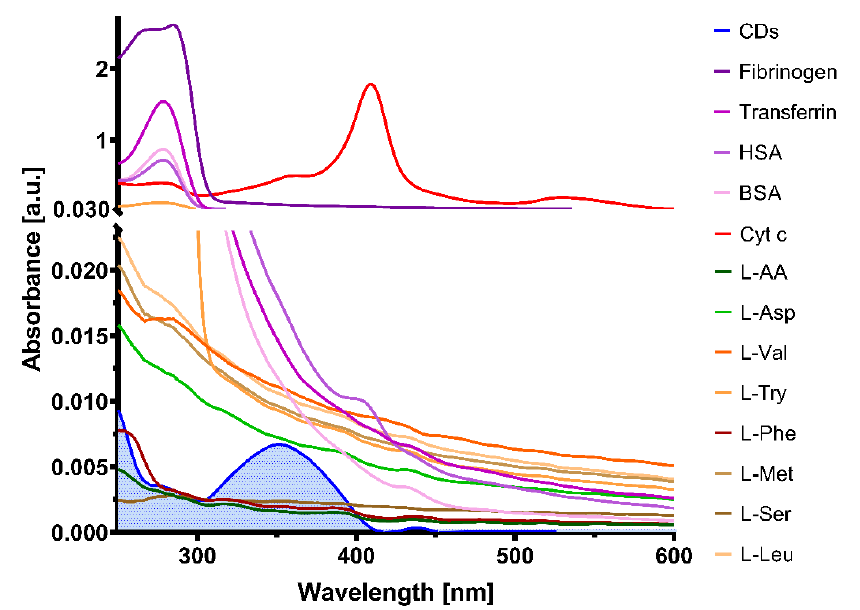
Figure 8. Absorbance spectra of different biological molecules that could interfere with the CQDs optical properties. The absorbance of CQD solution is highlighted in blue.